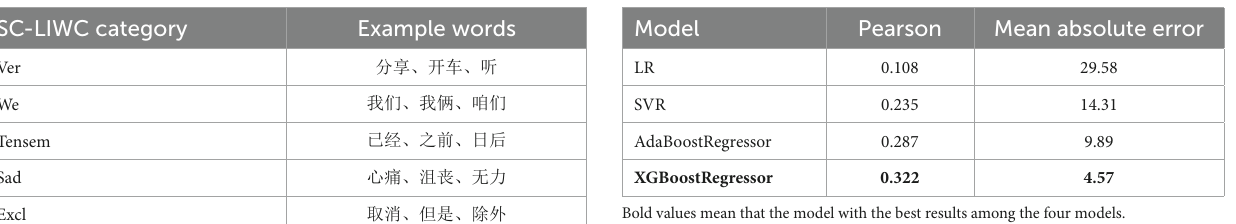
TABLE 4 Results of the model.